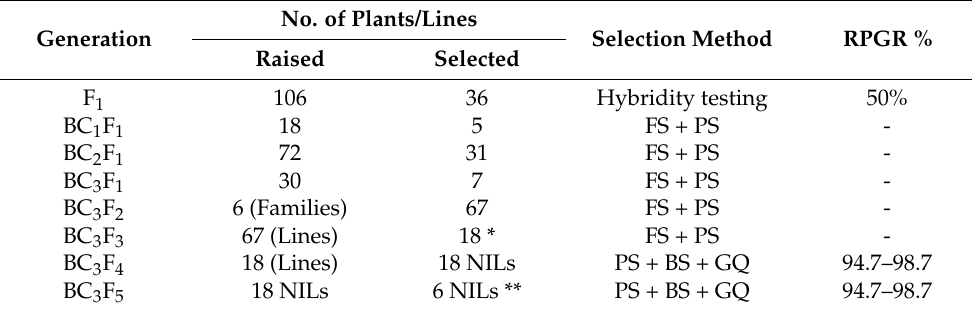
Table 2. Progressive selection statistics for Pusa 44 qDTY12.1 near isogenic